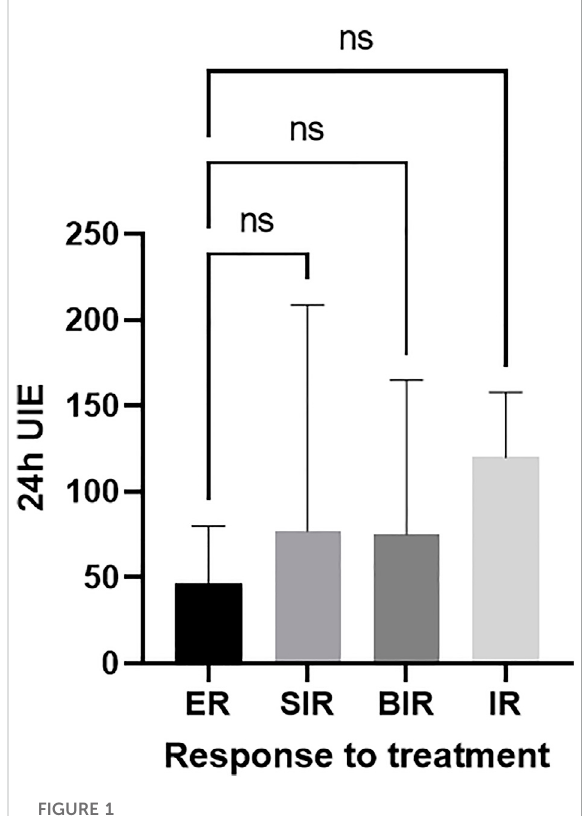
FIGURE 1 No difference between the 24-h UIE before RAI and best overall response to treatment (ER-reference group). ER, excellent response; BIR, biochemical incomplete response; SIR, structural incomplete response; IR, indeterminate response.